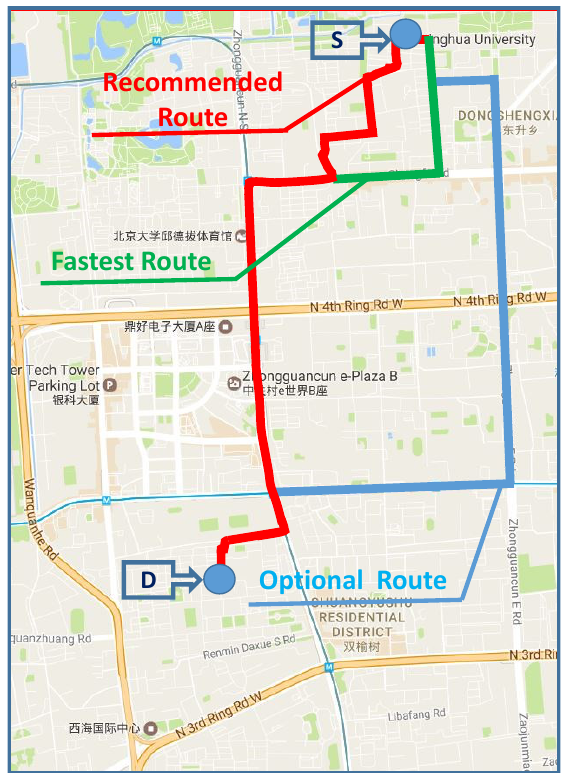
Figure 14. Illustration of the chosen routes when the initial battery SOC is 0.8. Table 6. The energy consumption and travel expense when the initial battery SOC is 0.8. Routes Fastest Route Items (4.8